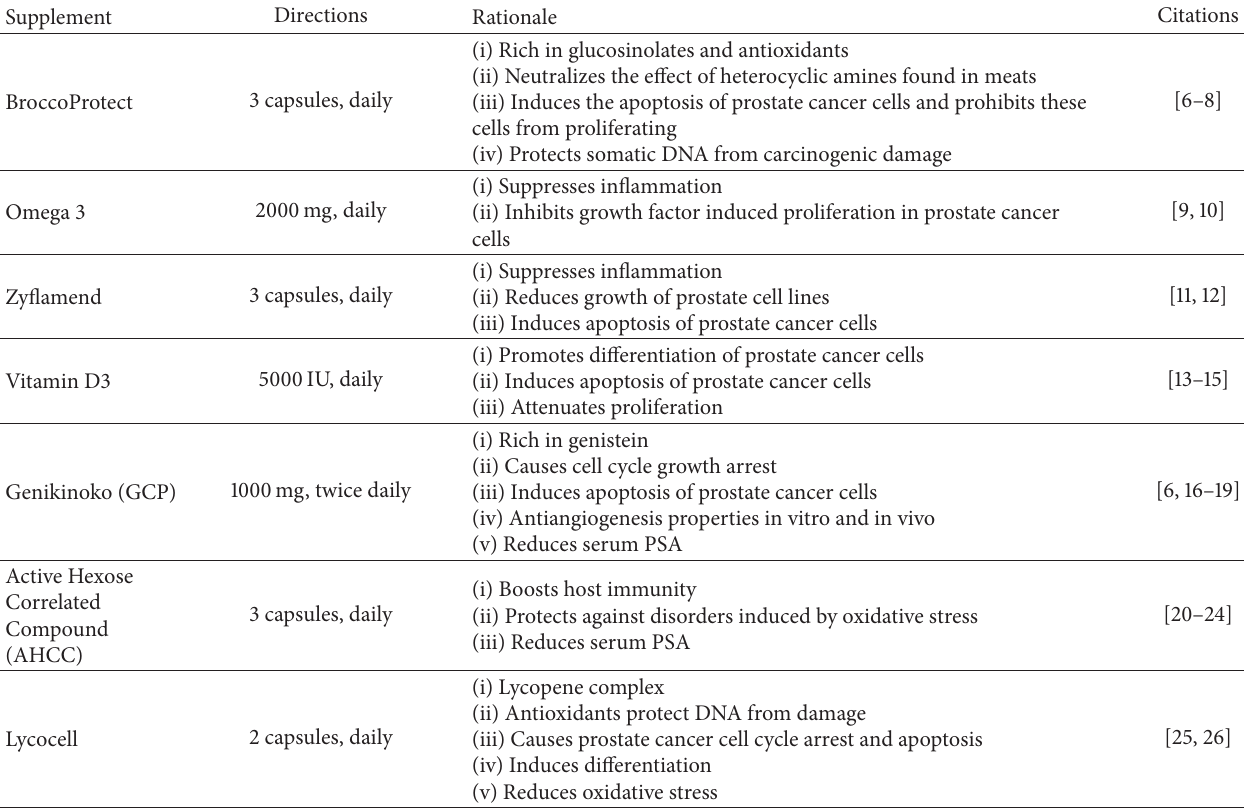
Table 1: Active Holistic Surveillance